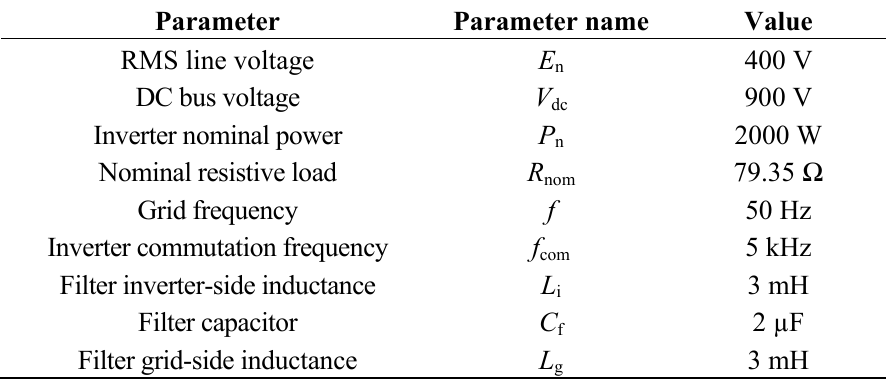
Table 1. Parameters used in